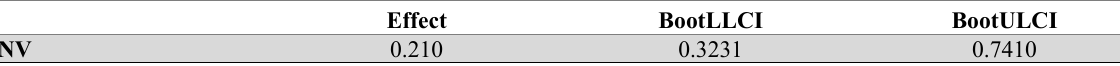
The indirect impact of environmental concerns